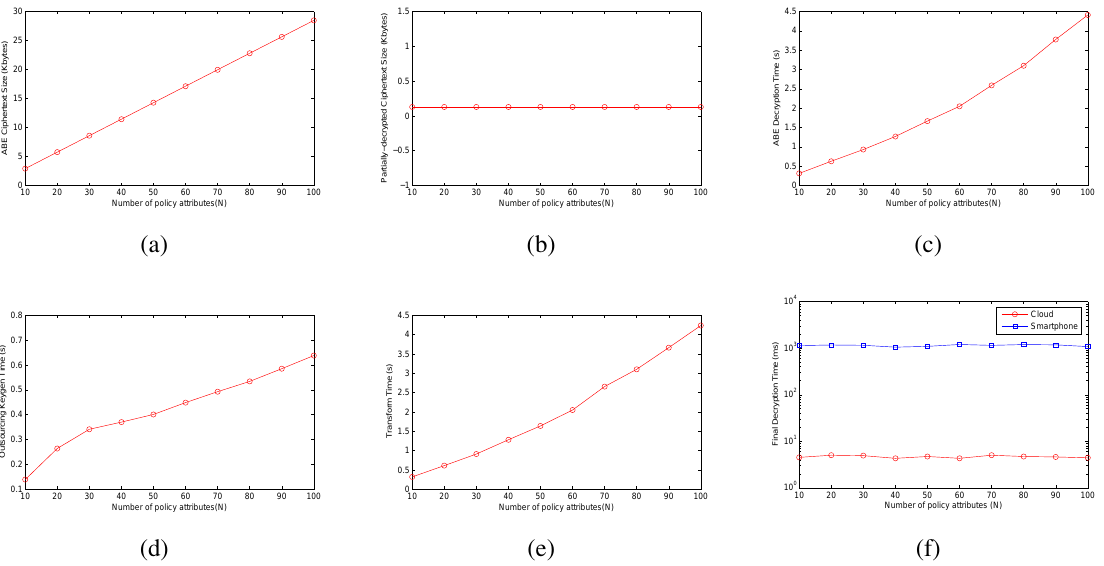
Figure 5. The performance of our ABE with outsourced decryption. ( a ) ABE ciphertext size; ( b ) partially-decrypted ciphertext size; ( c ) decryption time; ( d ) transformation keygen; ( e ) partial decryption time for the cloud; ( f ) final decryption